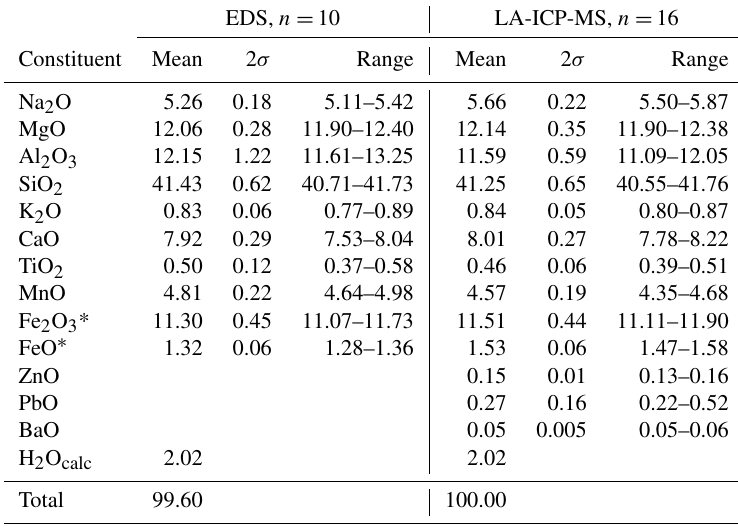
Table 1. Chemical data (in wt%) for ferri-taramite obtained with EDS and laser-ablation (LA) ICP-MS analyses. EDS, n = 10